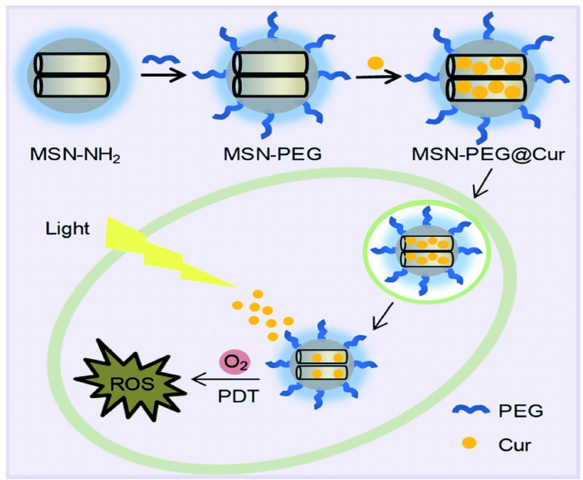
Figure 17. The preparation process for MSN-PEG@Cur and schematic representation of the intracel- lular photodynamic therapy (PDT) process after endocytosis of MSN-PEG@Cur. Reproduced with permission from [238], The Royal Society of Chemistry, 2020. This article is licensed under a